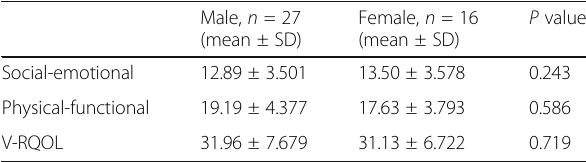
Table 6 V-RQOL means scores across the total, social-emotional, and physical functioning domains among males and females under the